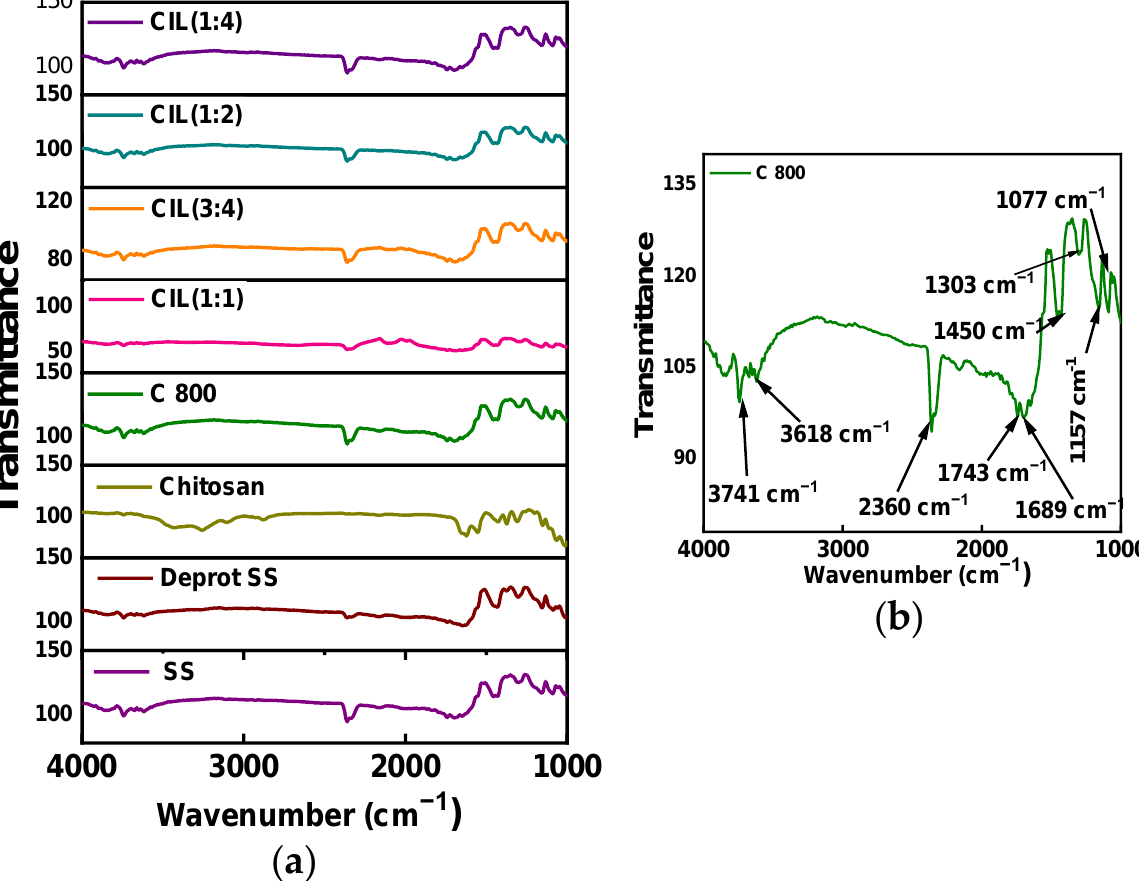
Figure 7. ( a ) FT-IR spectra of the synthesized materials and ( b ) FT-IR spectrum of